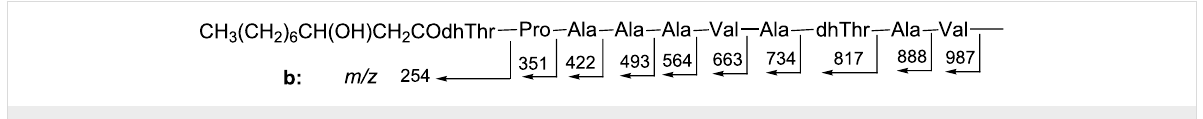
Figure 2: The segment identified based on the FABMS spectrum (peptide fragment b ions).